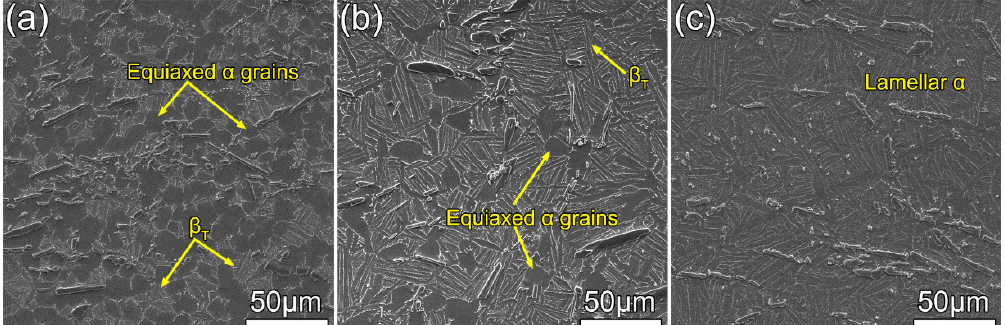
Figure 5. SEM micrographs of the Ti composites in various states: ( a ) HT1; ( b ) HT2; and ( c ) HT3. (The heat treatment conditions HT1–HT3 are listed in Table 1.)